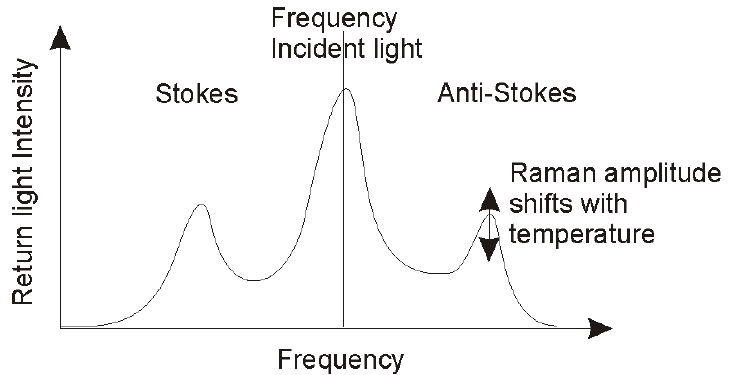
Figure 7. Sketch of the Raman scattering effect in fiber-optic. Incident light is scattered due to the interaction of photons with electrons. The Anti-Stokes amplitude varies with temperature. Note that Brillouin scattering [94] has been ignored on the